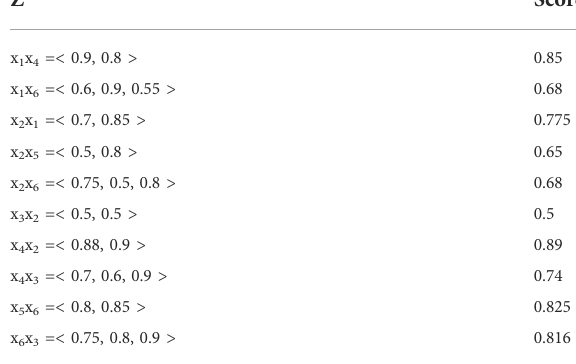
TABLE 10 Value of in fl uence of one person on another person.